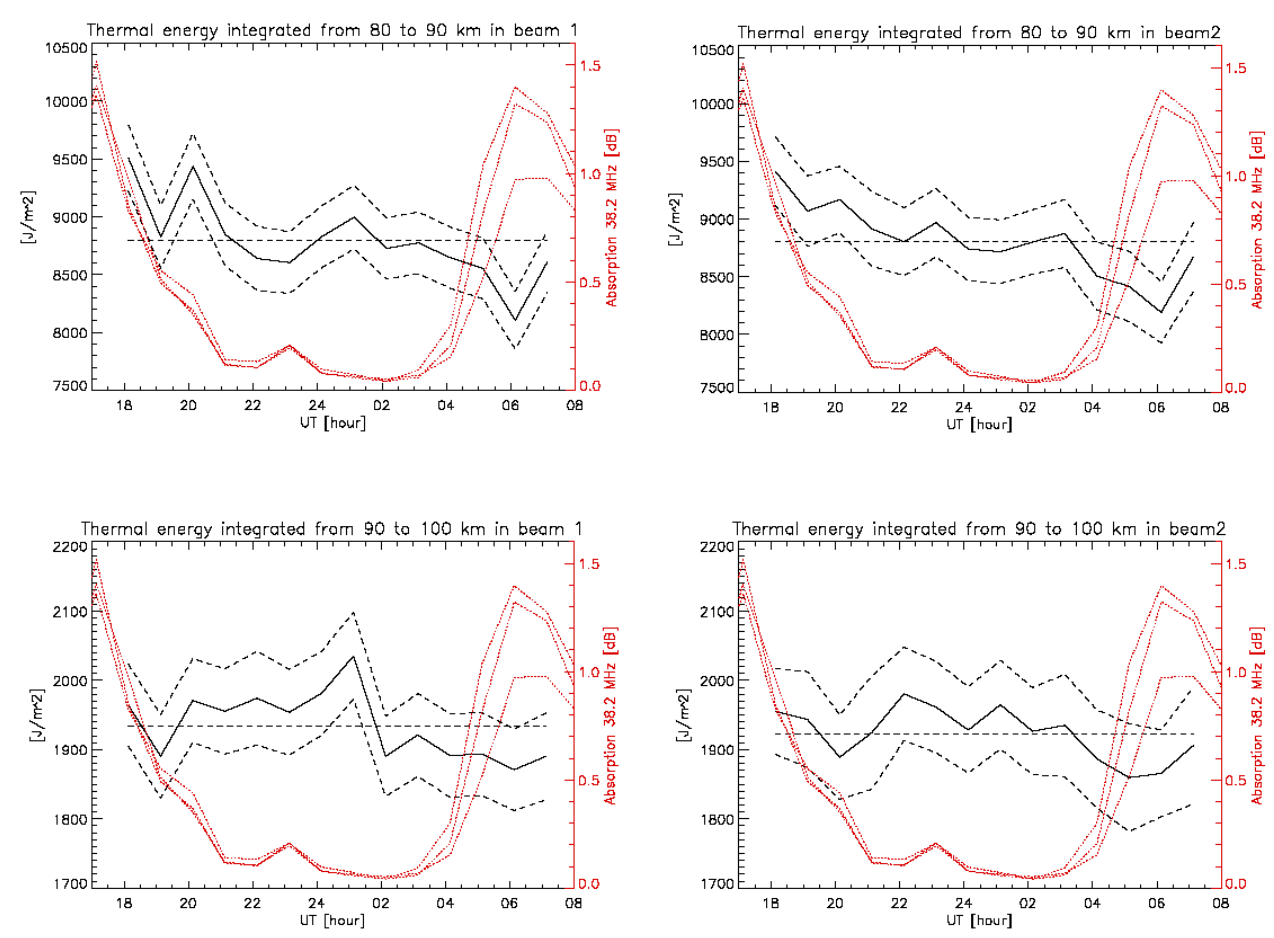
Fig. 12. The black solid line shows the thermal energy integrated from 80 to 90km and 90 to 100km in beam 1 (right column) and beam 2 (left column). The black dashed lines show the error estimate including 3% density variation in addition to the temperature uncertainties. The red dashed lines show the cosmic radio wave absorption measured by IRIS in beam 8, 15, and